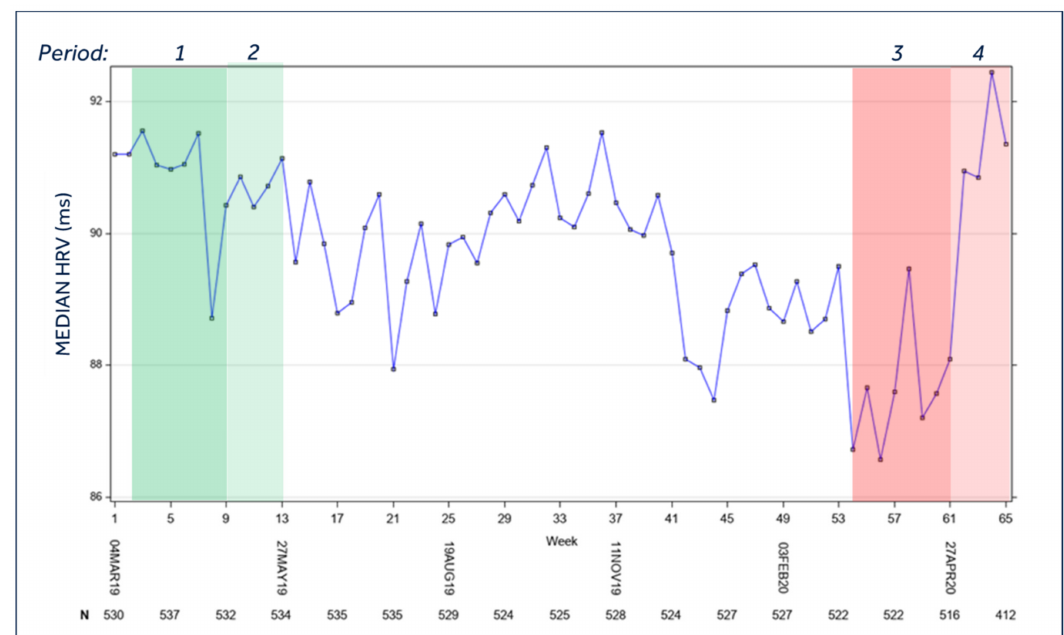
Figure 3. Median heart rate variability of the entire population during the study period. Legend: Period 1 = Lockdown control period (year 2019); Period 2 = Post-lockdown control period (year 2019); Period 3 = Lockdown period (year 2020); Period 4 = Post-lockdown period (year 2020). For the temporal definition of the three periods please see the Methods section; HRV = heart rate variability; p < 0.0001 for mean period 3 vs. mean period 1 , mean period 3 vs. mean period 4 ; p = 0.0018 for mean period 1 vs. mean period 2 ; p = N.S. for all other